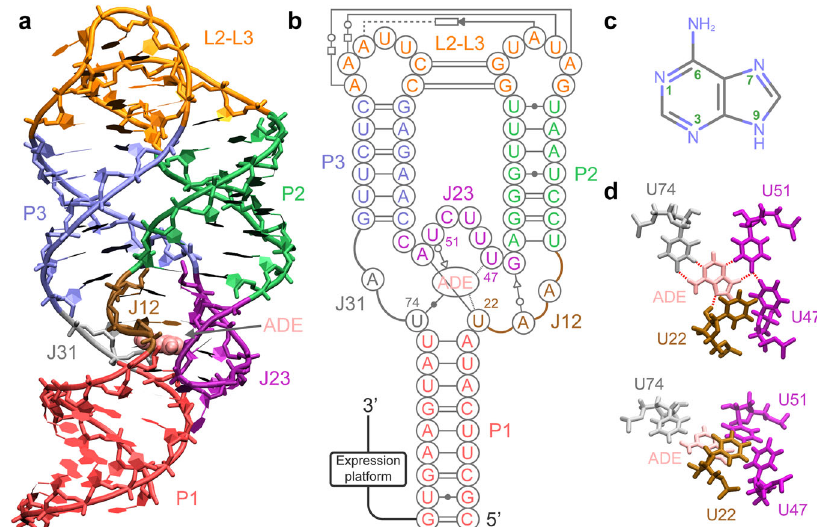
Fig. 1 The structure of add adenine riboswitch and the geometry of ligand binding pocket. a The tertiary structure of add adenine riboswitch in a complex with the adenine (ADE) ligand generated using VMD. The adenine ligand is depicted with a van der Waals representation, and each part of riboswitch is marked with different colors. b The secondary structure of add adenine riboswitch, which is marked similarly to the tertiary structure. The tertiary interactions are indicated with the notation of the Leontis – Westhof – Zirbel method 87 . For the purpose of clarity, several unimportant tertiary contacts are not shown. c Chemical structure of adenine molecule (nitrogenous groups are identi fi ed in light blue). d The top and top-side views of ligand binding pocket. The hydrogen bonds are indicated by red dashed lines (top view), and the base stacking information in the binding pocket is shown in top-side